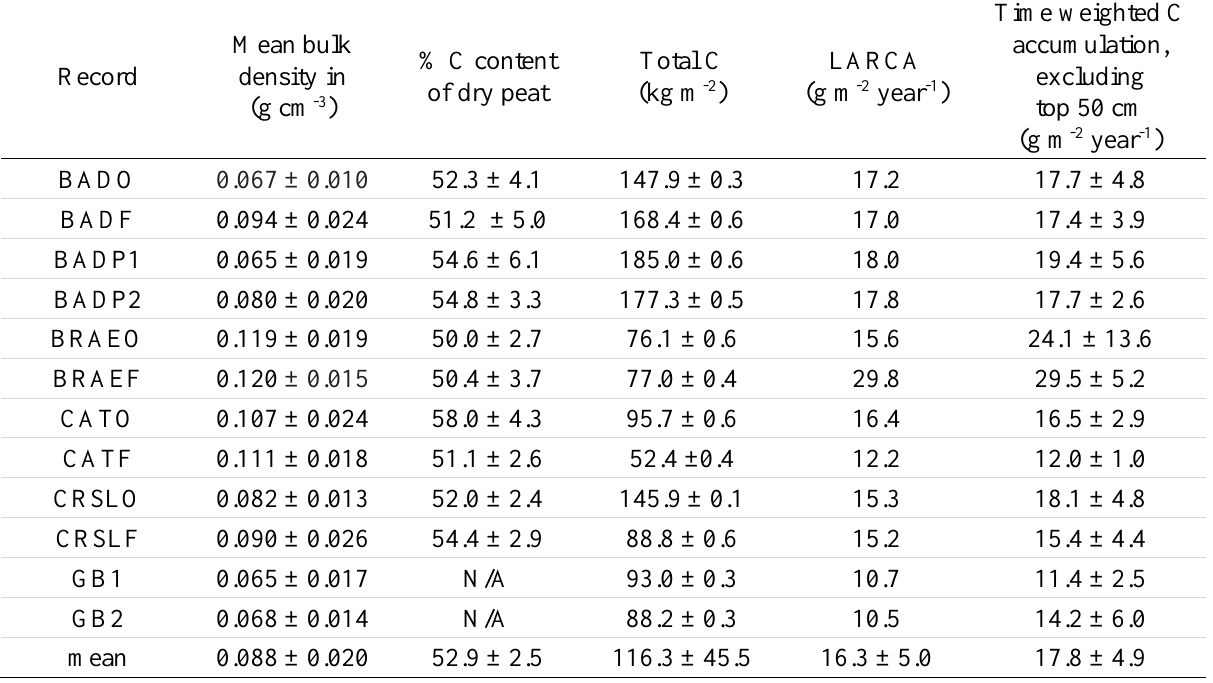
Table 5. Summary data for new and re-analysed records. The values reported are means ± standard deviation. Standard deviations were derived using the values for every segment in each core. Summarised data are provided for bulk density, % C content of dry peat, total C accumulated from the base of the peat to the surface, the long-term apparent rate of C accumulation (LARCA) which is provided for comparability purposes, and the time weighted C accumulation which excludes the upper 50 cm to avoid inclusion of undecomposed acrotelm